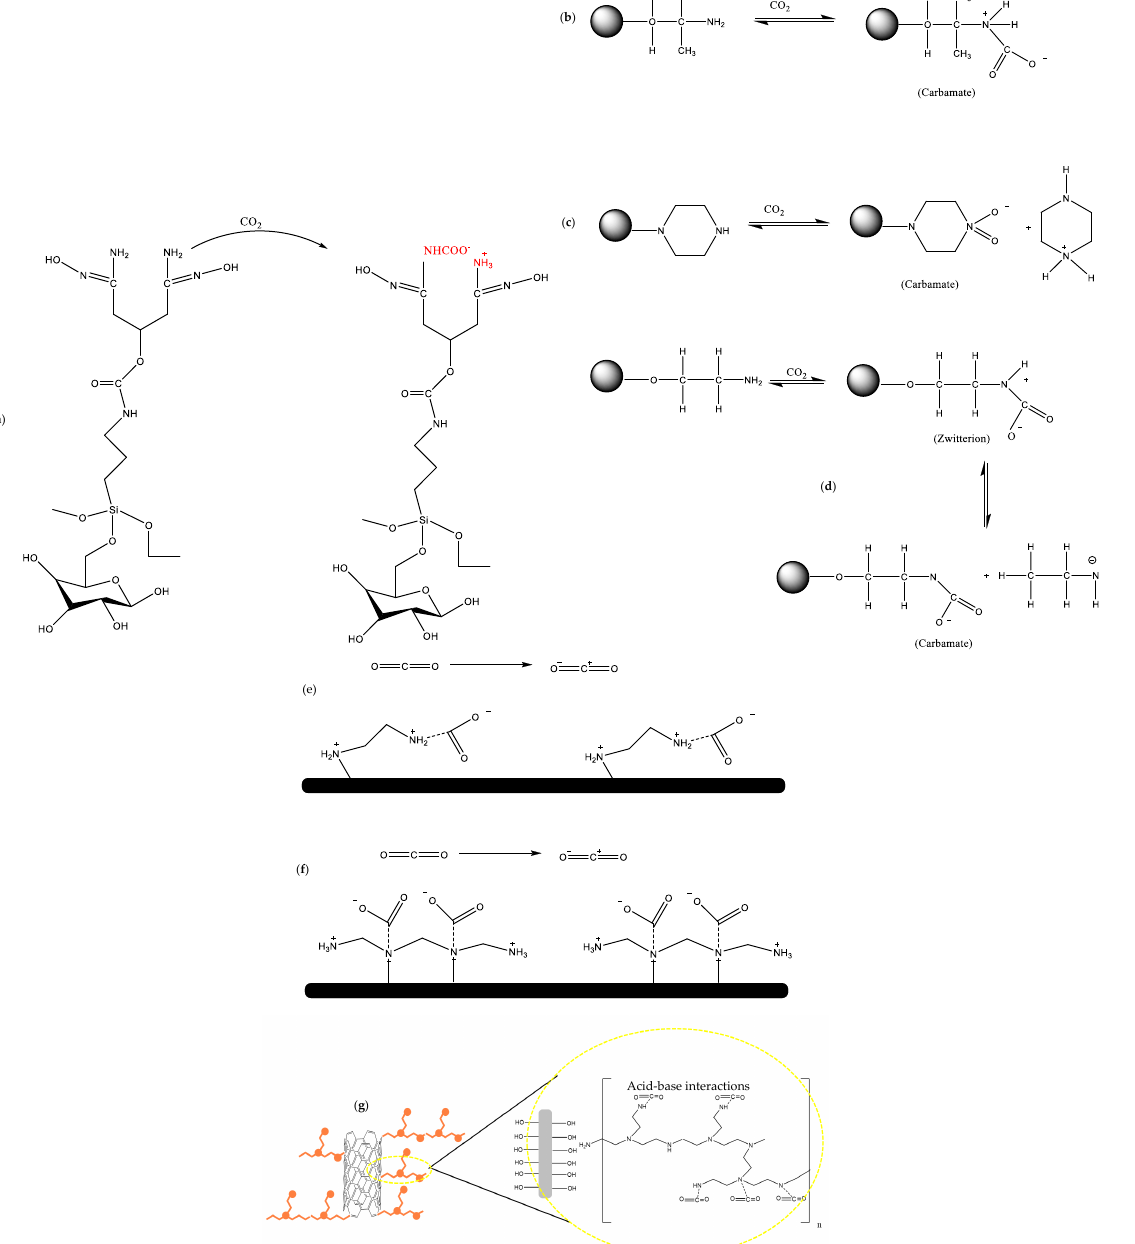
Figure 10. Reactions between the CO 2 molecules and ( a ) amidoxime, ( b ) AMP, ( c ) PZ, ( d ) MEA, ( e ) EDA, ( f ) TETA, and ( g ) PEI functionalities (Reprinted with permission from ref. [51,110,215,222,226]). 4.6. Importance of Moisture in the Effective Capture of CO 2 by Amine-Functionalized Porous Carbon Adsorbents The presence of moisture plays a dominant role in determining the CO 2 adsorption performance of amine-functionalized porous carbon materials. Moisture is ubiquitous in the flue gas and ambient air [8,14,62,108]. The possible reactions occurring between the CO 2 molecules and the primary, secondary, and tertiary amines under dry and moist con- ditions are presented in Table 12.